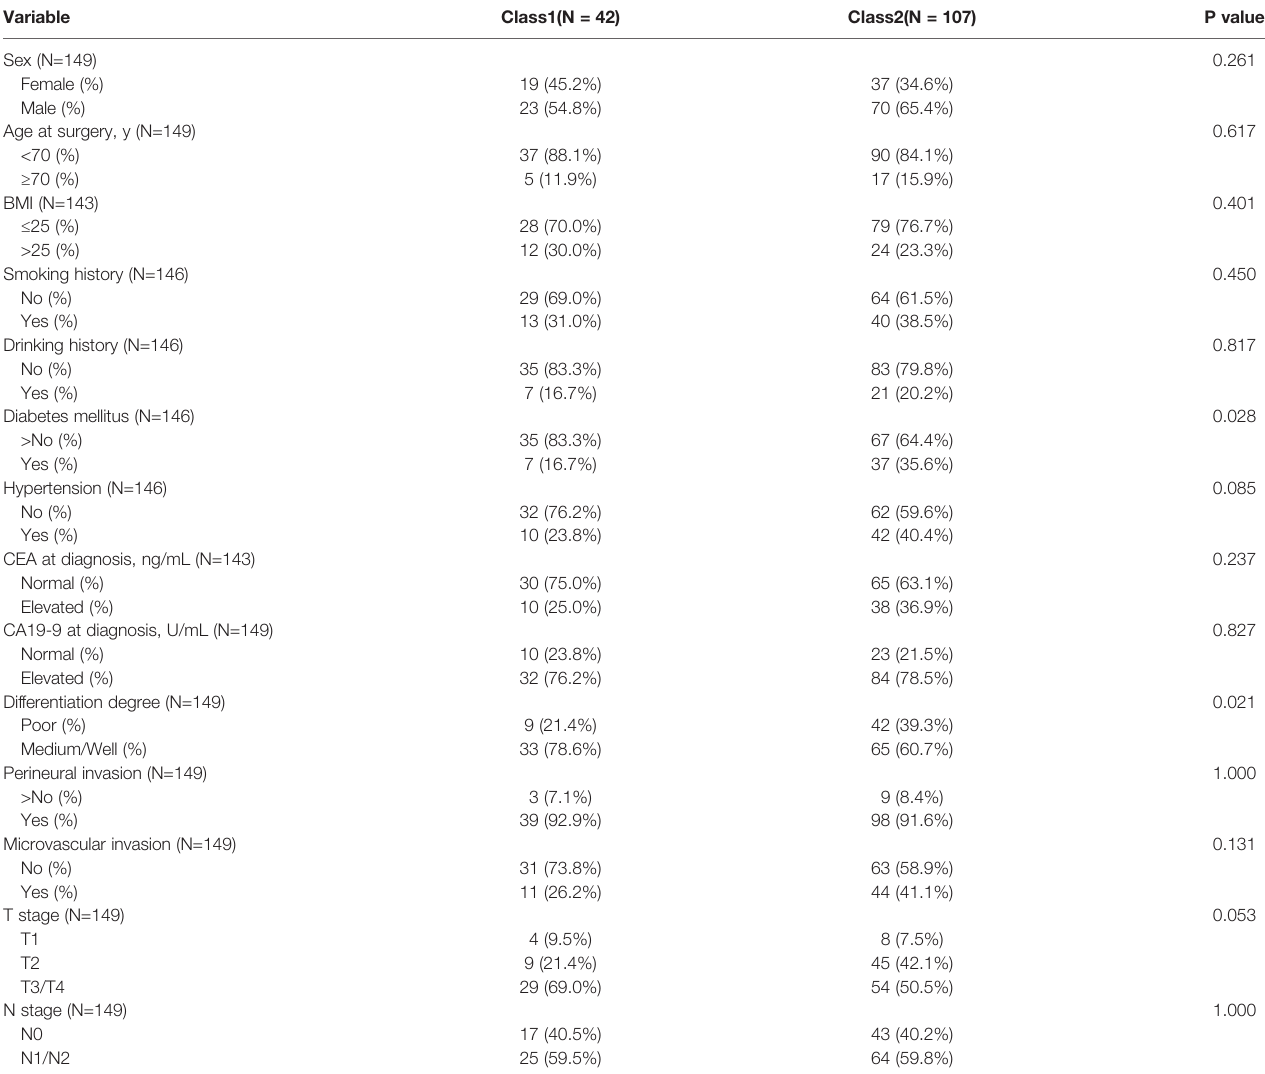
TABLE 1 | Comparison of clinicopathological characteristics between class1 and class2 in spectral clustering.